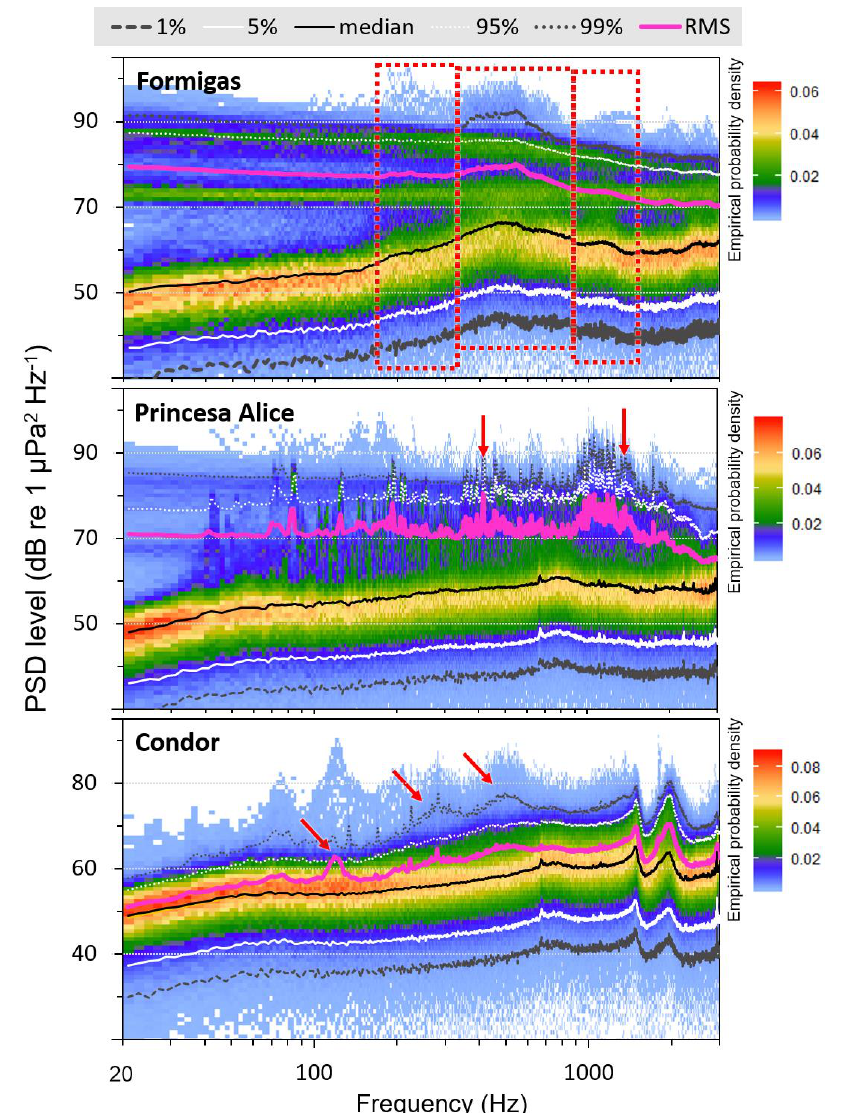
Figure 5. Spectral Probability Density levels (SPDs), percentiles and Root Mean Square (RMS) level of 4 days of recordings from June 2010 for the three seamounts: Formigas, Princesa Alice and Condor. SPDs were produced for each 1 s time segments using an FFT size of 4096 points.